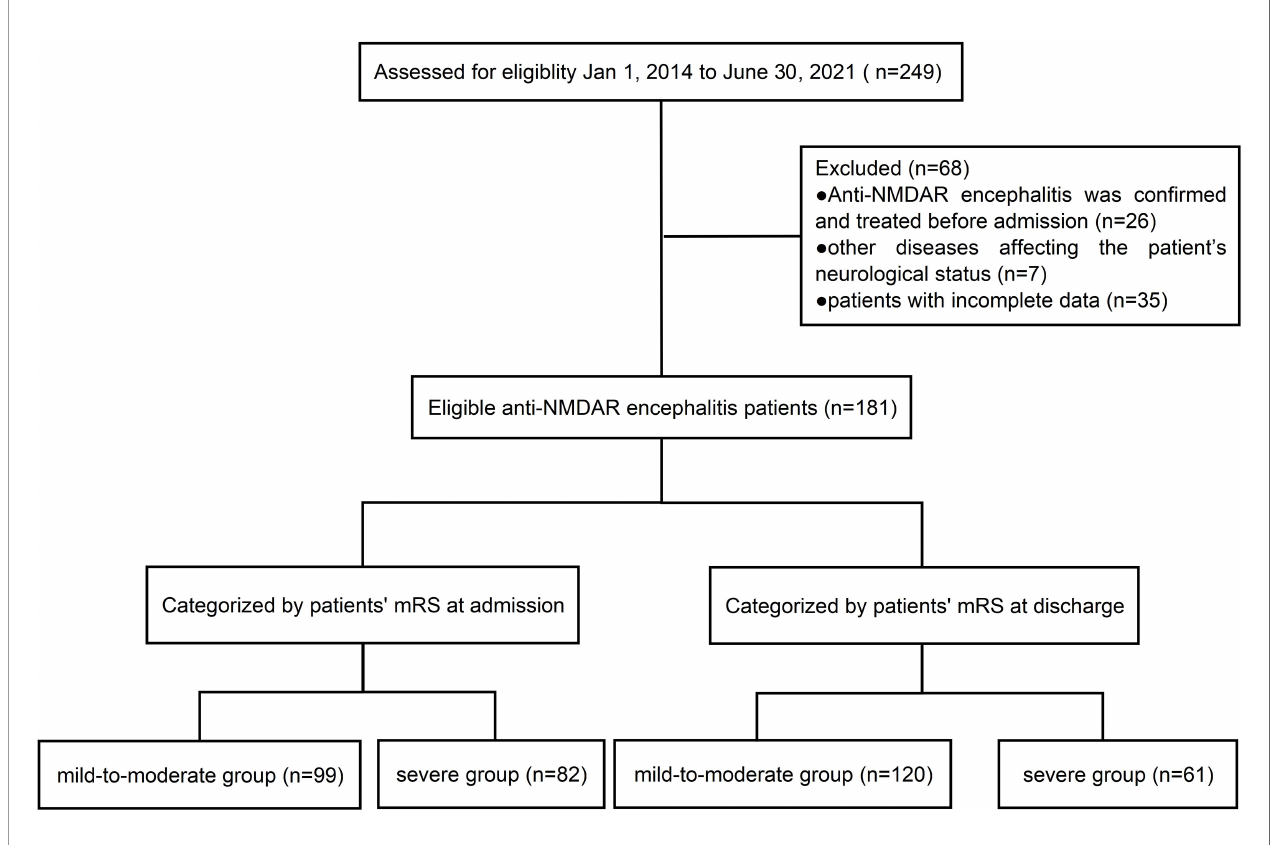
FIGURE 1 | Cohort selection process of the study